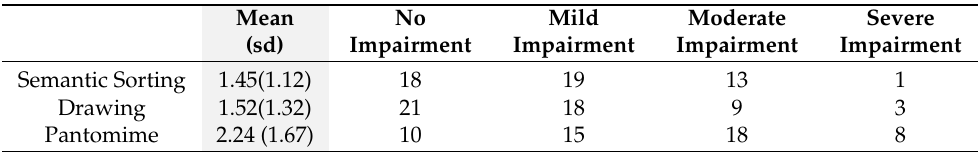
Table 1. Degree of impairment across tasks. First column (shaded), mean (sd) of normalized scores; columns 2 to 4, numbers of participants for each severity level (see Table A1 in the Appendix A). Mean No (sd) Impairment